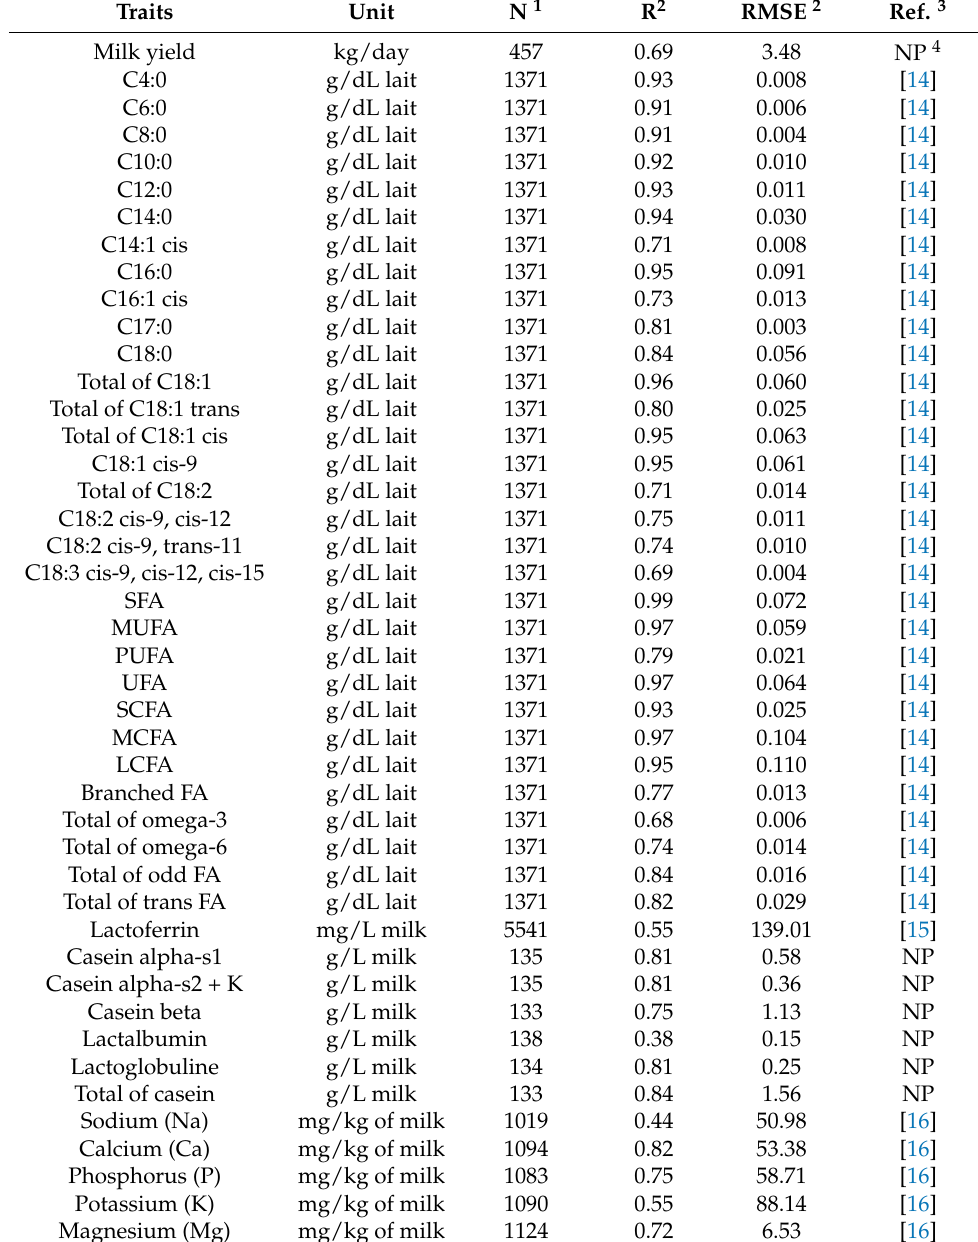
Table 1. Specifications of equations used to provide the used predictors. Traits